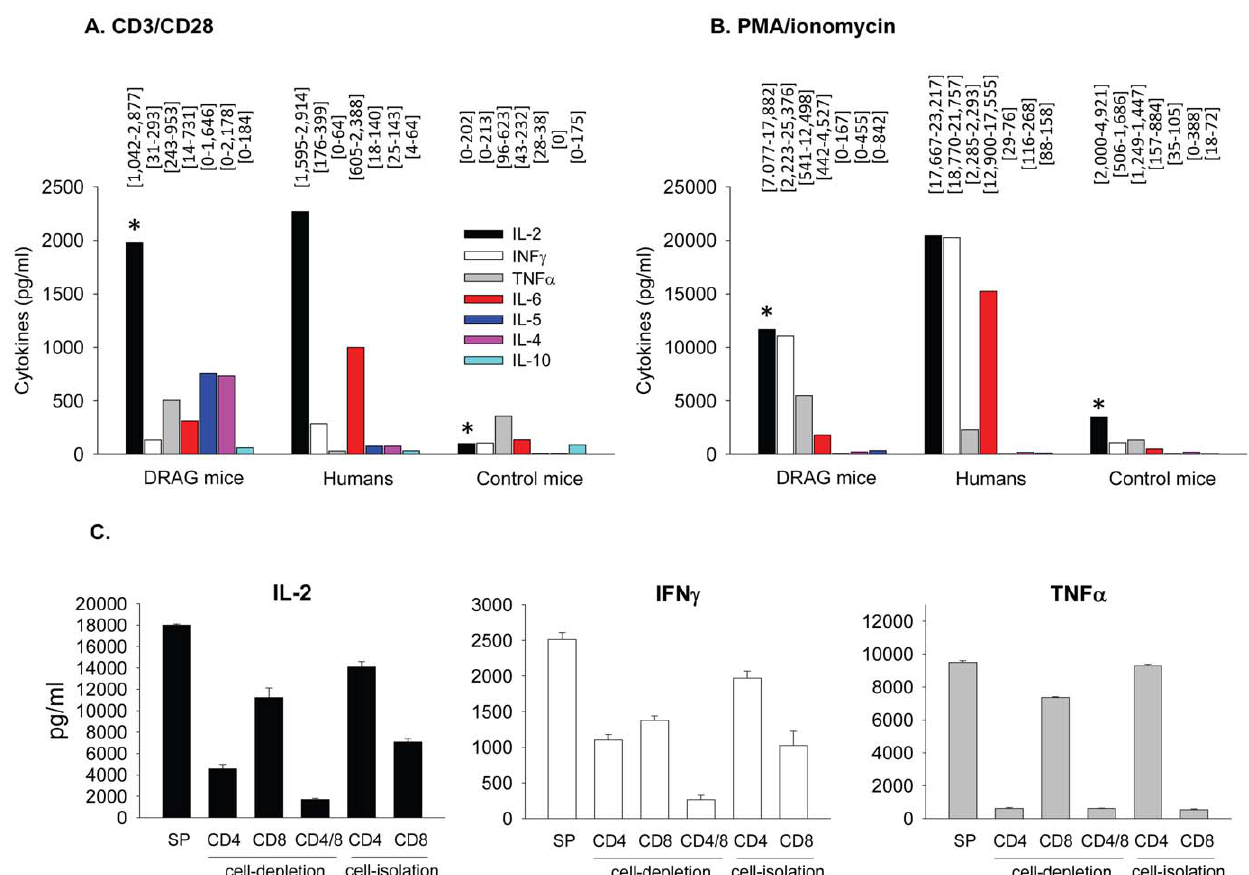
Figure 4. Human T cells developed by DRAG mice are functional. At 6 months post-infusion of HSC, splenic cells (3 6 10 5 ) from DRAG (n=4) and control mice (n=2) as in figure 2, were stimulated for 24 h with anti-human CD3/CD28 Abs (panel A) PMA/ionomycin (panel B) or left unstimulated, and cytokines secreted in supernatants were measured by Luminex. Non-stimulated cells secreted insignificant levels of human cytokines ( , 50 pg/ml). Data represent mean values of mice analyzed individually over the background levels of non-stimulated cultures. Ranges are indicated over the plots. T cells from DRAG mice secreted significantly higher levels of IL-2 upon stimulation with CD3/CD28 Abs or PMA/ionomycin as compared to control mice (p values=0.013 and 0.025, respectively using the Independent sample t-test). Panel C, cell-depleted spleens or positively isolated CD4 T and CD8 T cells from pooled spleens of two additional DRAG mice were stimulated in vitro with PMA/ionomycin for 24 h or left unstimulated. Non-stimulated cell cultures produced insignificant levels of human cytokines ( , 50 pg/ml). Data represent the mean 6 SD of duplicated samples over the background levels of non-stimulated cells. Similar results were obtained in a second independent experiment.